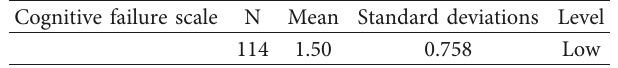
Table 6: Means and standard deviations of students’ scores on the cognitive failure